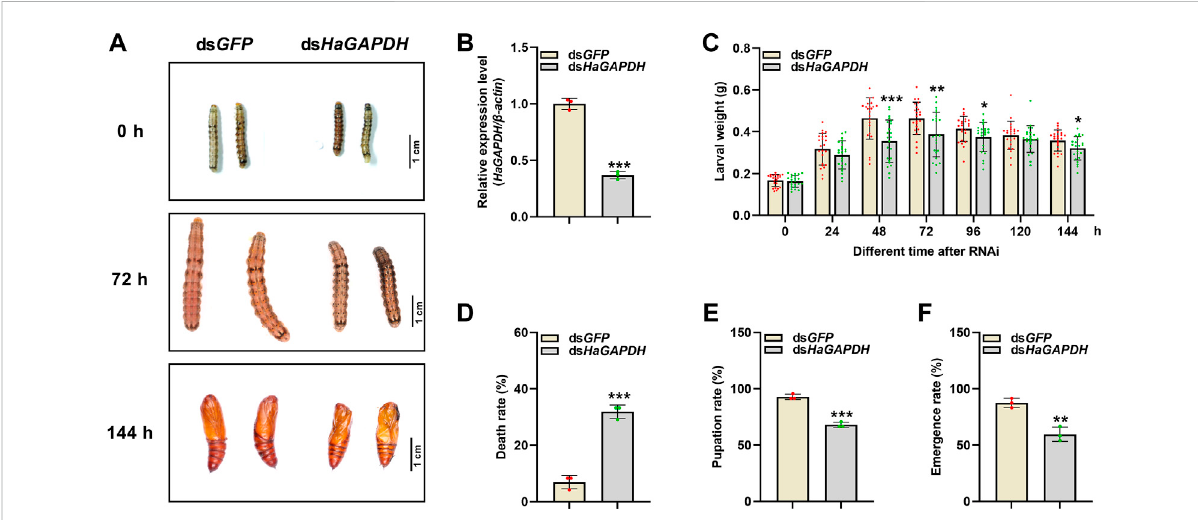
FIGURE 4 Effectsonthesixthinstarlarvaeafterknockdownof HaGAPDH (A) and (B) theknockdownphenotypes (A) andef fi ciency (B) of HaGAPDH onthe sixth instar larvae. The larvae were injected with 5 μ g ds HaGAPDH or ds GFP (the control); then, photographs were taken at different timepoints, and midguts were collected for qRT-PCR at 24 h. β -actin was used as the reference gene. Error bars indicated the mean ± s.d. of three independent biological experiments andthree technical repetitions.*** p < 0.001; Student ’ s t- test. (C) Larvalweightchangesafter beinginjectedwith ds RNA for 24, 48, 72, 96, 120, and 144 h. There were 30 larvae in each group, and three independent biological experiments were performed. Each dot representedarepetition, andtheerrorbarsindicated mean±SE.* p < 0.05, ** p < 0.01,and*** p < 0.001;Student ’ s t- test. (D – F) Statisticalanalysesof the death rate (D) , pupation rate (E) , and emergence rate (F) after ds RNA injection. There were 30 larvae in each group. The error bars indicated